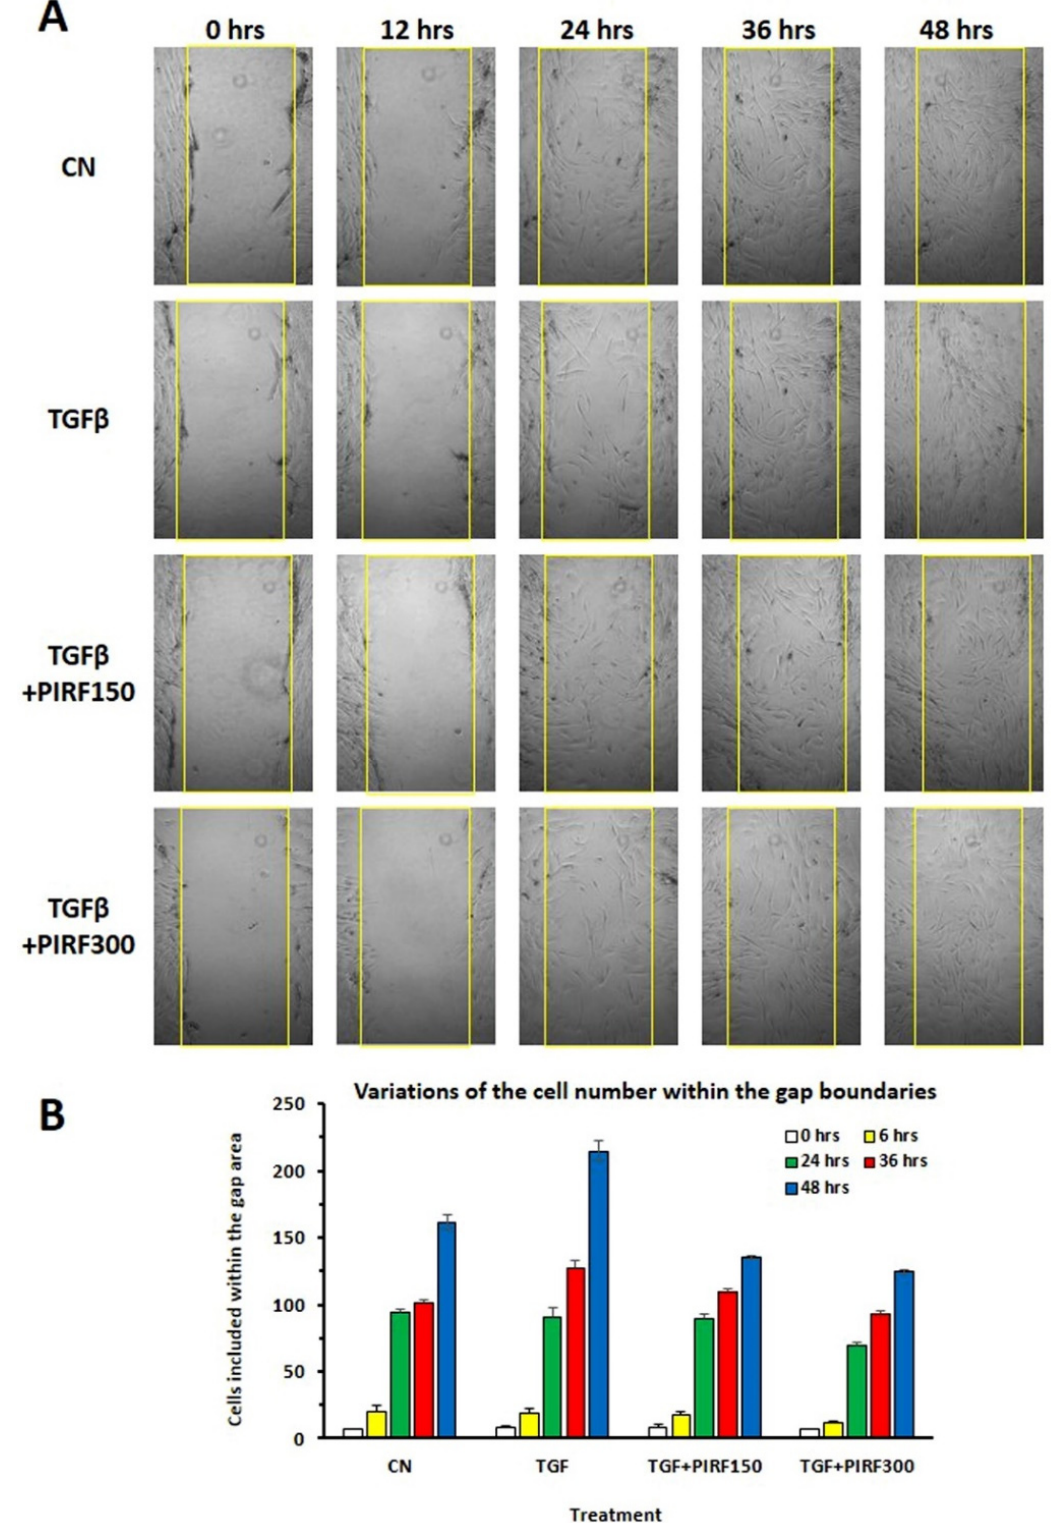
Figure 8. Wound scratch assay. ( A ) The migratory capacity of the SCI13D cells, in the presence or absence of TGF- β and/or pirfenidone (PIRF), was assessed by acquiring images of the cells filling in the lesion gap (yellow lines) at the indicated timepoints (0, 6, 24, 36, and 48 h); ( B ) histograms quantify the cell numbers within the lesion boundaries, at each timepoint, for each treatment. Cells were scored in three images for each timepoint and treatment.